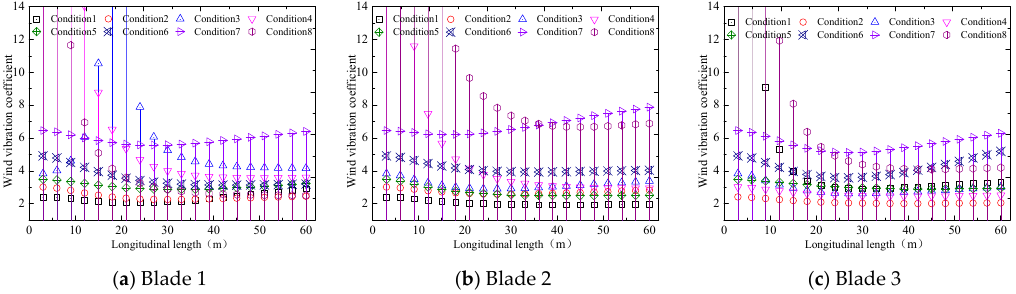
Figure 32. Wind fluttering factor distribution of blades under different conditions when the downwind displacement was used as the equivalent goal.